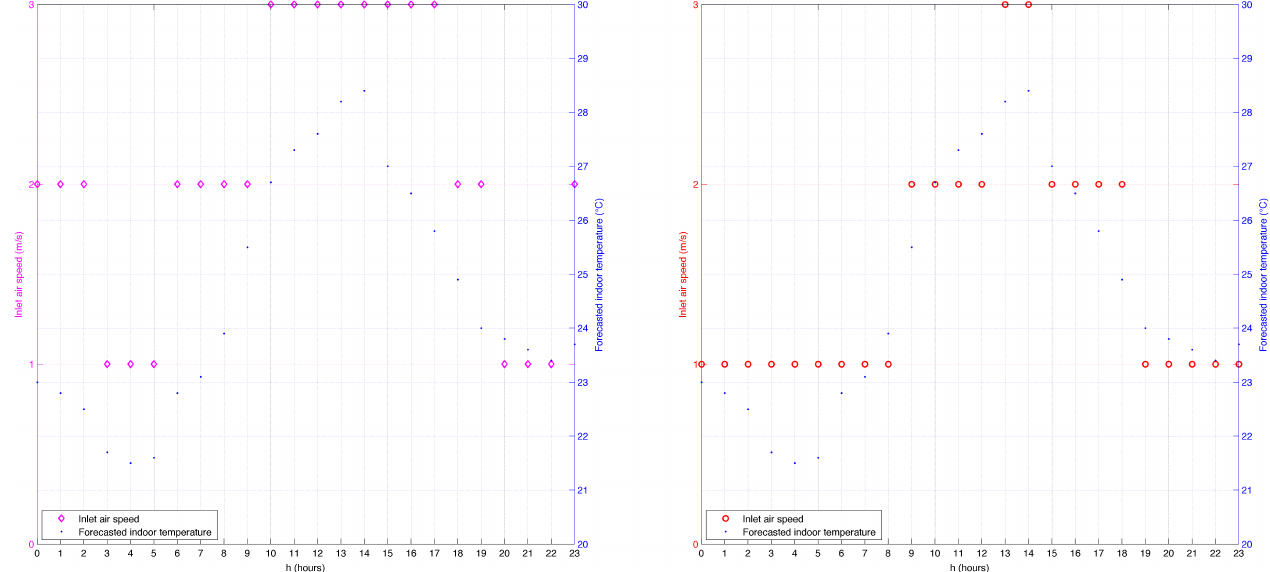
Figure 8. Summer scenario: ON/OFF speed of the HVAC system. The approach proposed in [20] ( left ); The approach proposed in this paper ( right ). Reproduced with permission from [20], Copyright 2014 Elsevier.